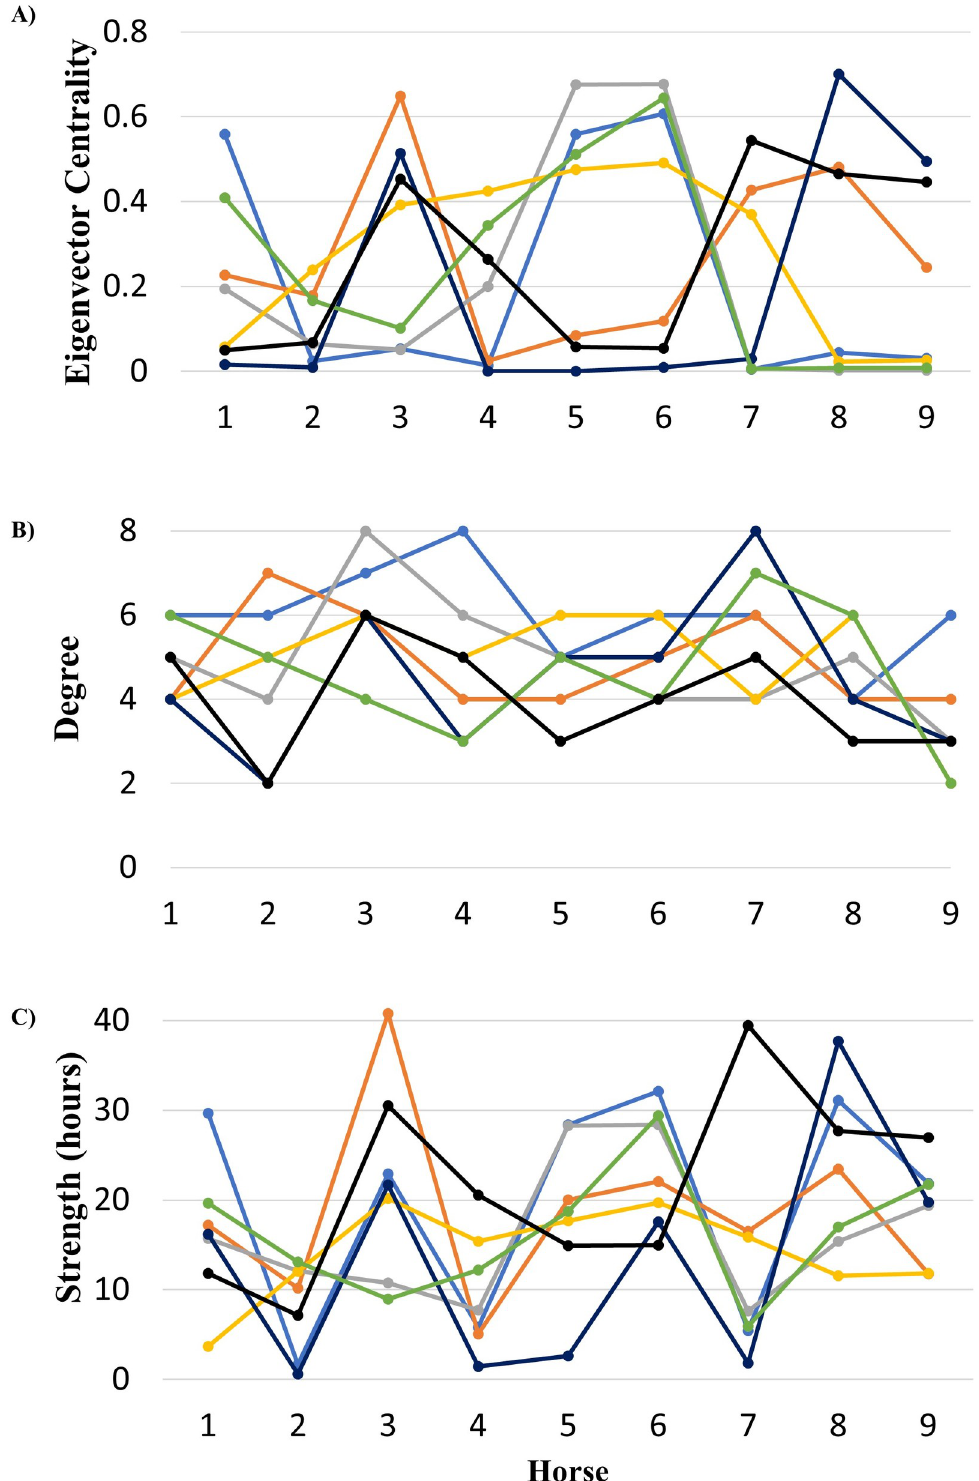
Fig 7. Selected centrality measures for each horse on each study day. Centrality measures include eigenvector centrality (A), degree (B), and strength (C). Each day, a different horse was the most central horse (day 1 = light blue, day 2 = orange, day 3 = grey, day 4 = yellow, day 5 = dark blue, day 6 = green, day 7 = black). The eigenvector